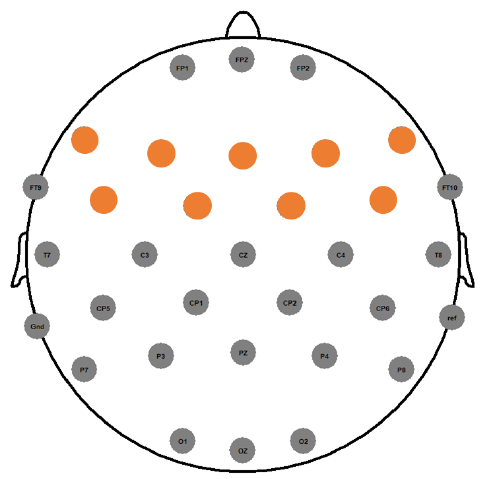
Figure 2. EEG montage for the present study. Colored channels were analyzed in the